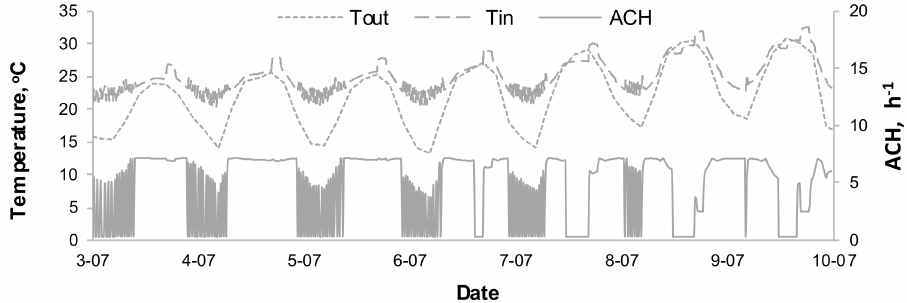
Figure 11. Variation of T out , T in and ACH in living room during one chosen